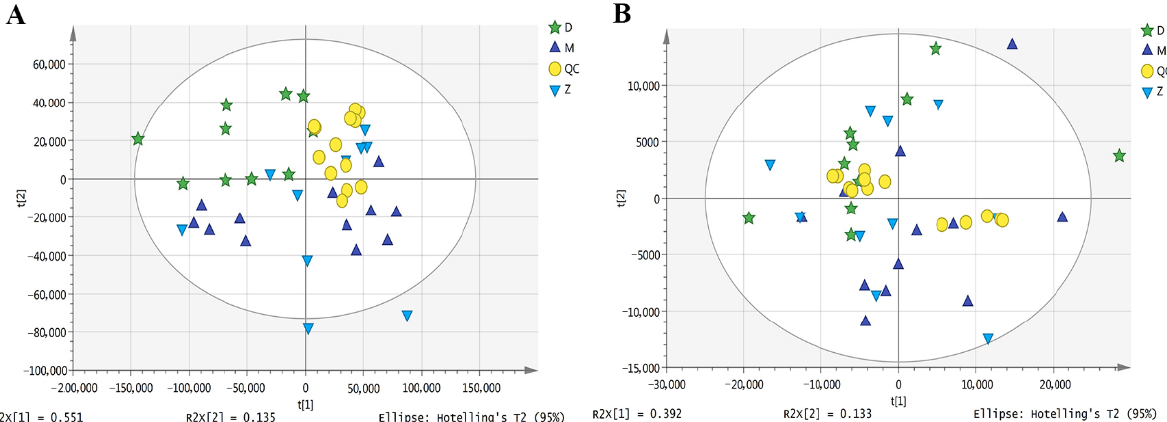
Figure 1. The principal component analysis (PCA) scores plot of metabolomic data in both positive ( A ) and negative ( B ) ionization modes. D indicates milk samples from Mediterranean buffalo; M indicates milk samples from Murrah buffalo; QC means samples of Quality control; Z indicates milk samples from crossbred buffalo.